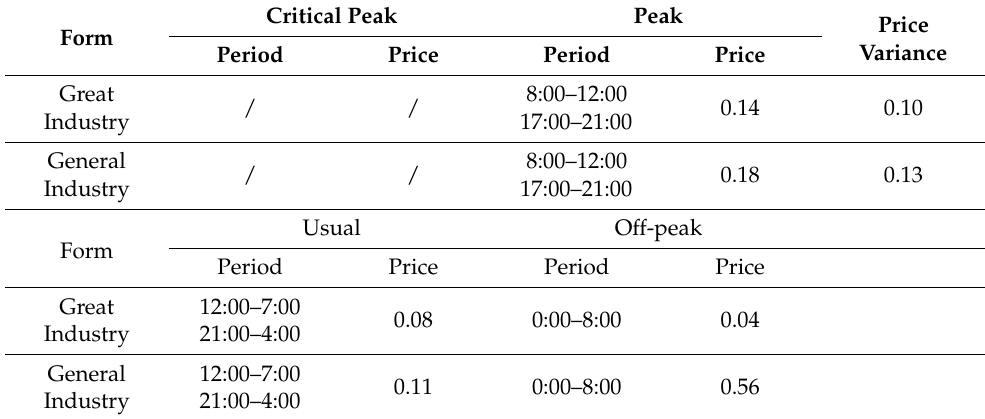
Table 2. Time-of-use electricity price ( € /MWh).